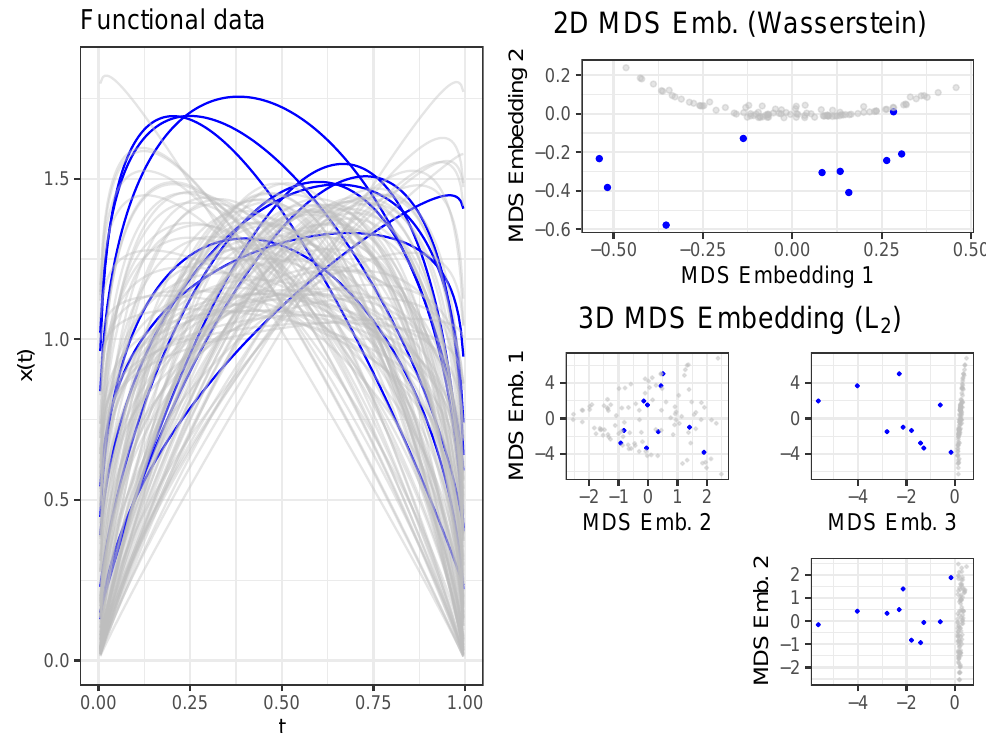
Figure 4. Functional outlier scenario ( n = 100, r = 0.1) with vertical shifts inducing structural differences. MDS embeddings based on unnormalized L 1 -Wasserstein distances and L 2 (Euclidean) distances on the